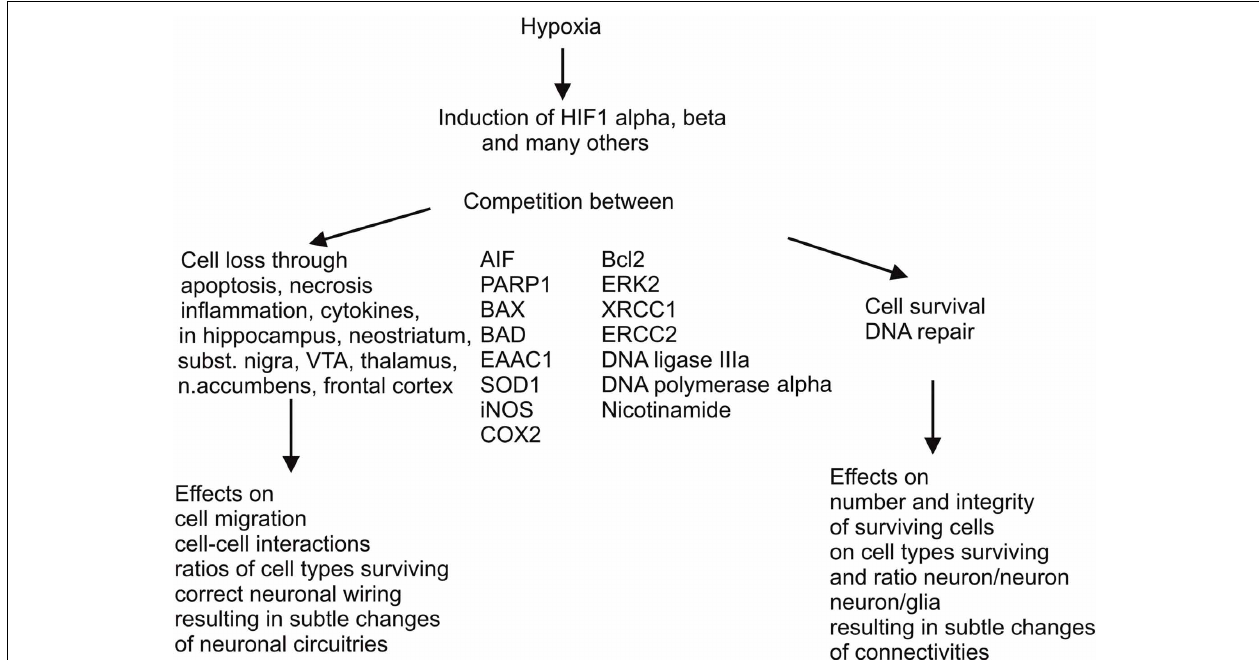
FIGURE 1 | Antagonistic molecular and cell cascades elicited by perinatal asphyxia. There are two important molecular and cell cascades elicited by perinatal hypoxic insults, one leading to removal of cells damaged by the reduced supply of oxygen, implying activation of ubiquitination, peroxisomal, and caspase pathways, resulting in apoptosis or necrosis, the latter encompassing mild to severe inflammation. The other cascade is activated for compensating cell loss by multiple mechanisms of DNA repair. Naturally occurring nicotinamide with its